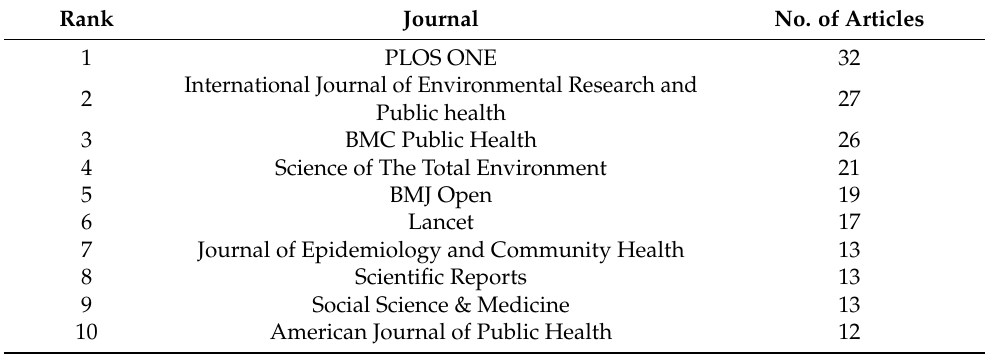
Table 2. The core 10 journals publishing articles on premature mortality, with the number of publications.